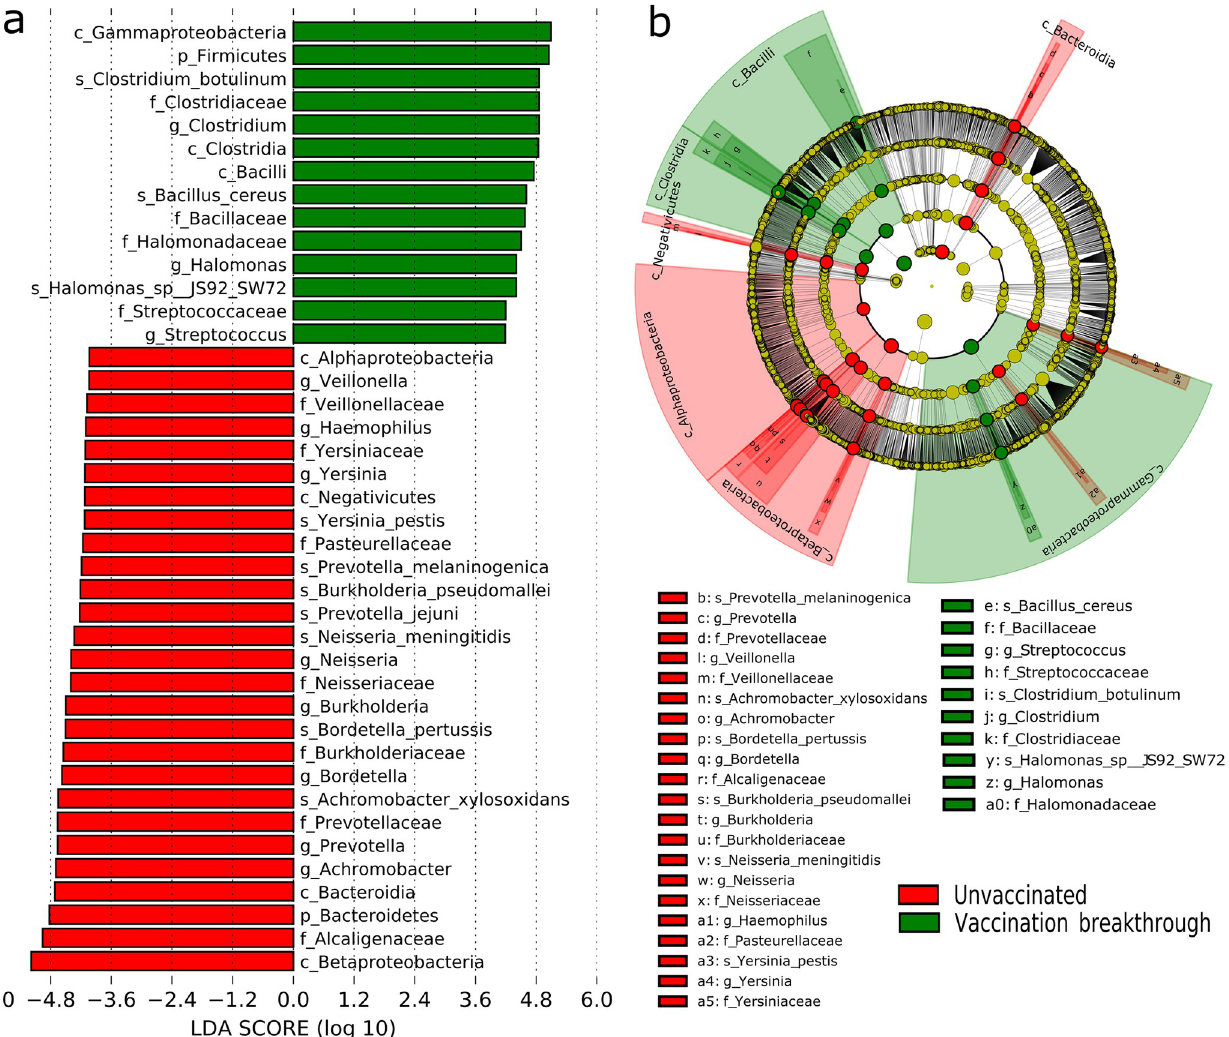
Fig 3. Microbial features across unvaccinated and vaccination breakthrough cohorts. (a) Cladogram (b) Histogram. Differential taxa between two groups selected on the basis of discriminative features by LEfSe analysis (LDA scores > 4.0). Green and red indicate taxa enriched in the vaccination breakthrough and the unvaccinated patients, respectively. Depiction of the most abundant microbes at different levels in each group: k, kingdom; p, phylum; f, family; c, class; g, genus; s,